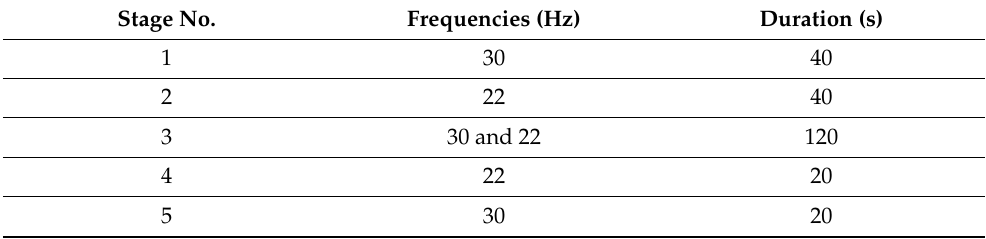
Table 1. Protocol of the laboratory experiment. Stage